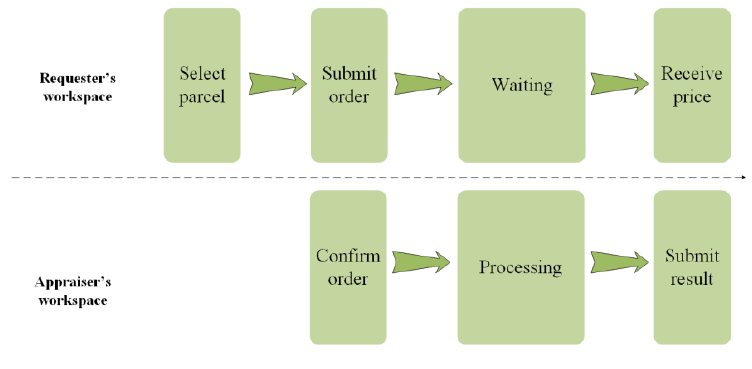
Figure 2. Task flow.